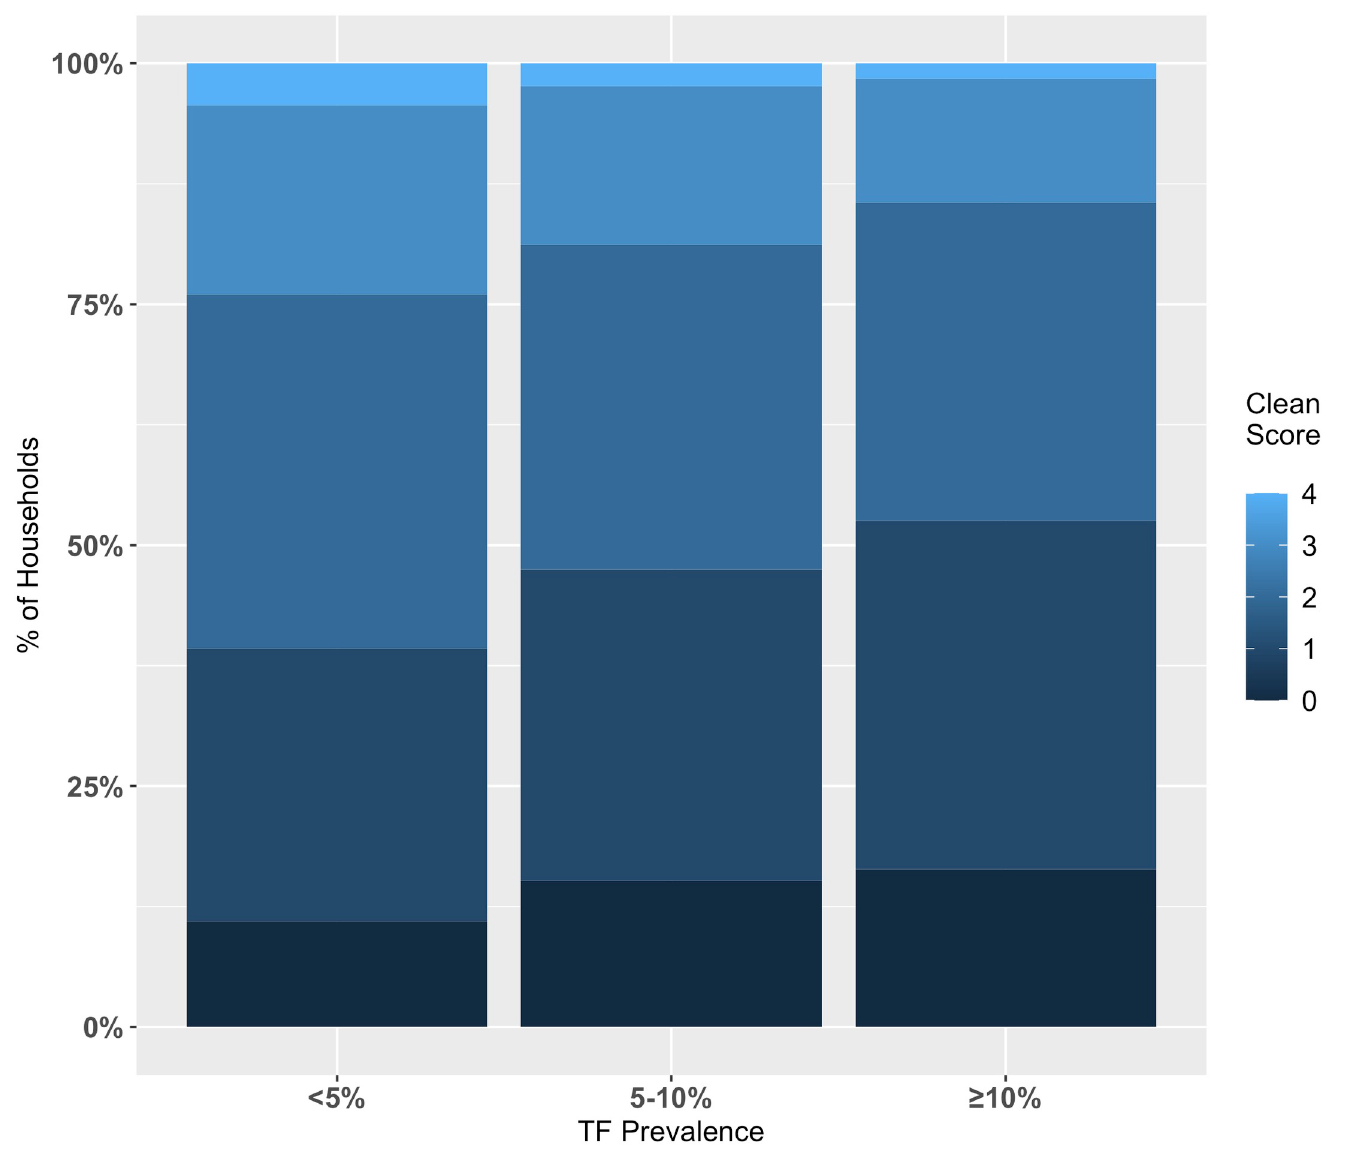
Fig 4. The percentage distribution of household cleanliness index scores according to community prevalence of trachoma. The household cleanliness index score is a summary score of the number of the following markers present and ranges from 0–4: a clean yard, clothes washed and drying around the house, an improved latrine, and at least one child in the household having a clean face. Each of the four components in the index is a binary variable (1 = yes, 0 =